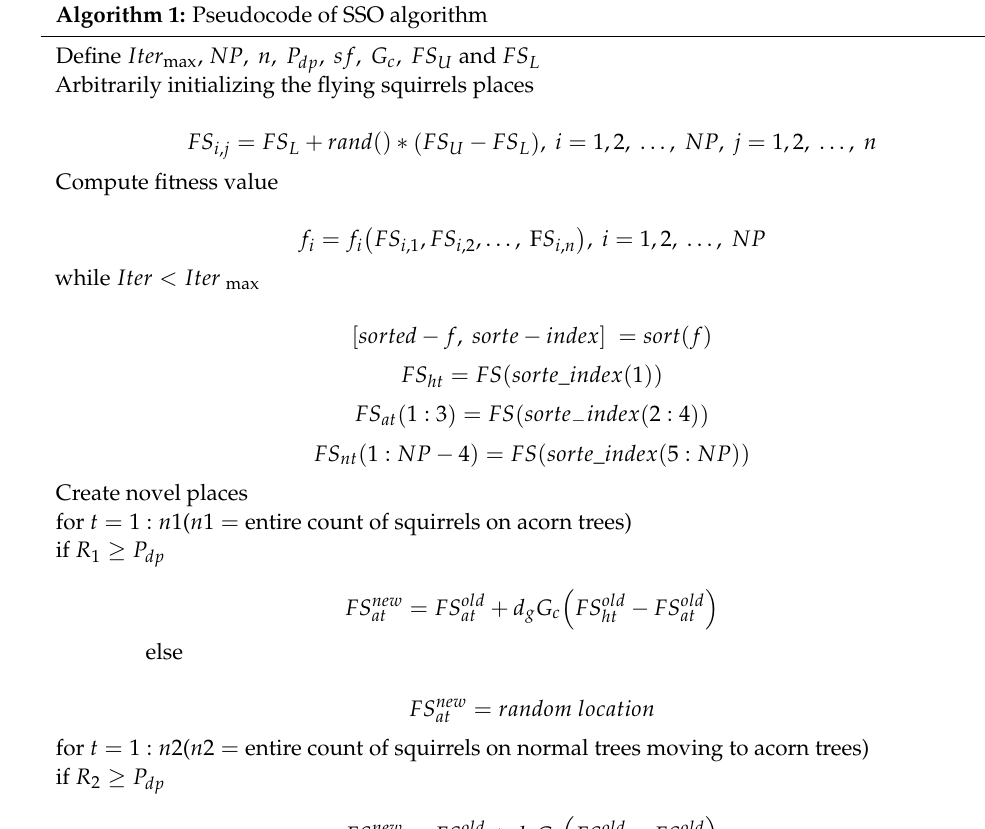
Algorithm 1: Pseudocode of SSO